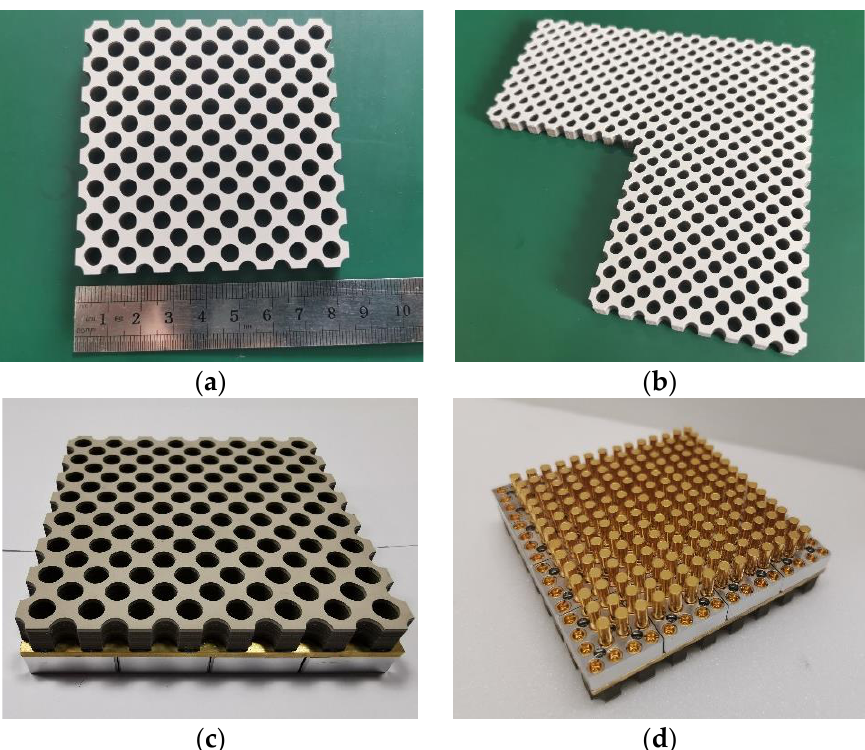
Figure 3. Proposed dual polarized 128-element PUMA prototype ( a ) plan view of a prototype (multiple PCB section); ( b ) three modular proposed PUMAs; ( c ) PUMA array with copper ground plate and bolted modular feed tiles; ( d ) backshot of PUMA array with SSMP loads.